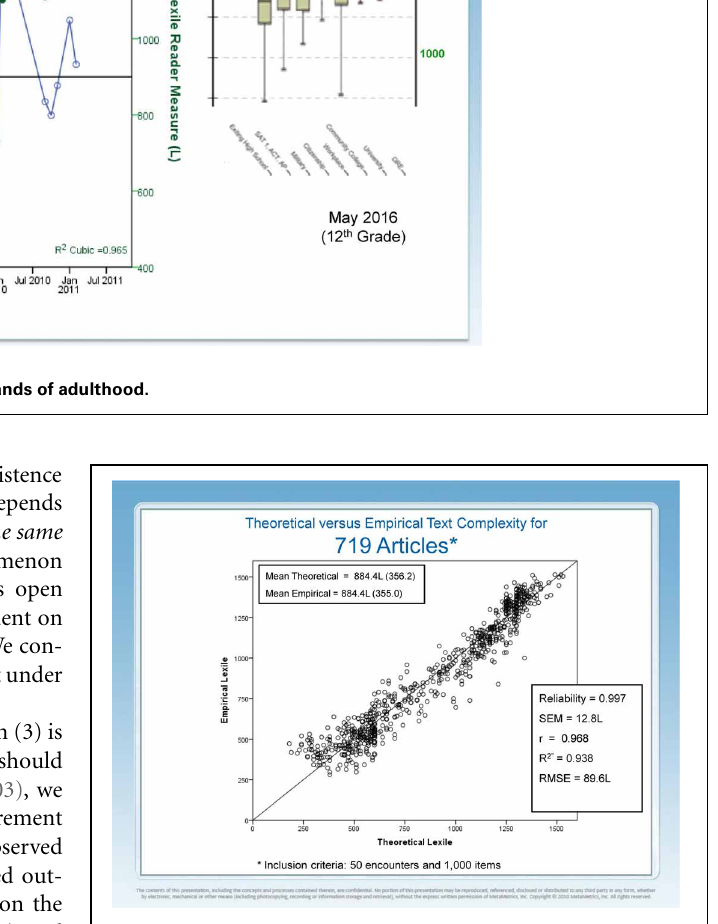
FIGURE 2 | Predicted vs. observed text complexity